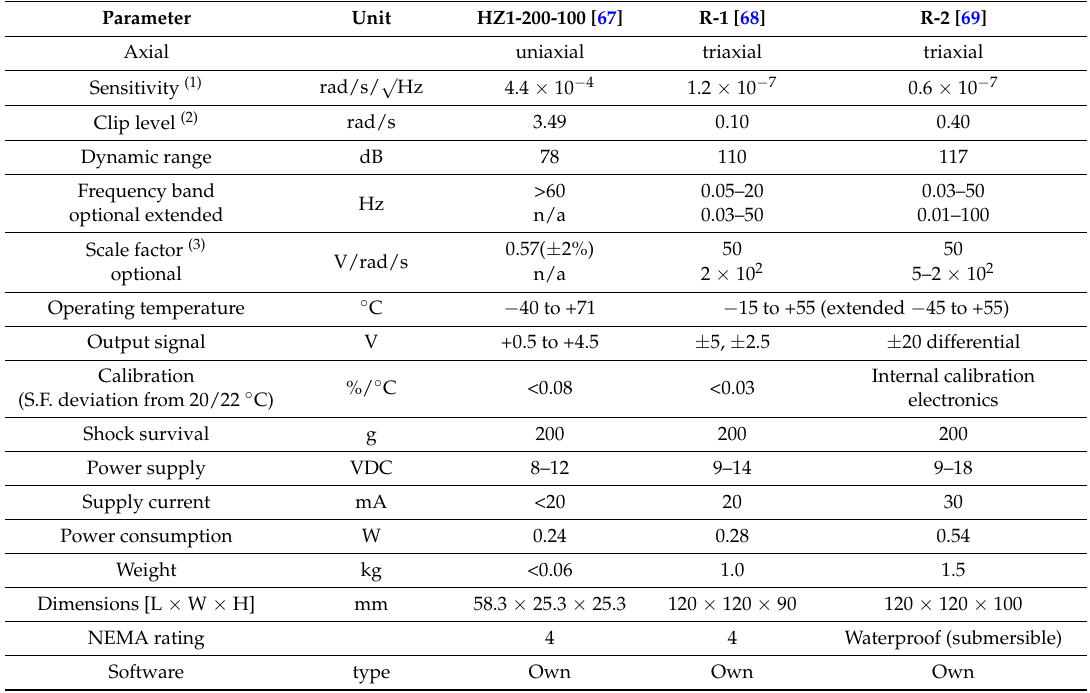
Table 2. Overview of rotational seismometers using direct measurement (only the most important parameters are